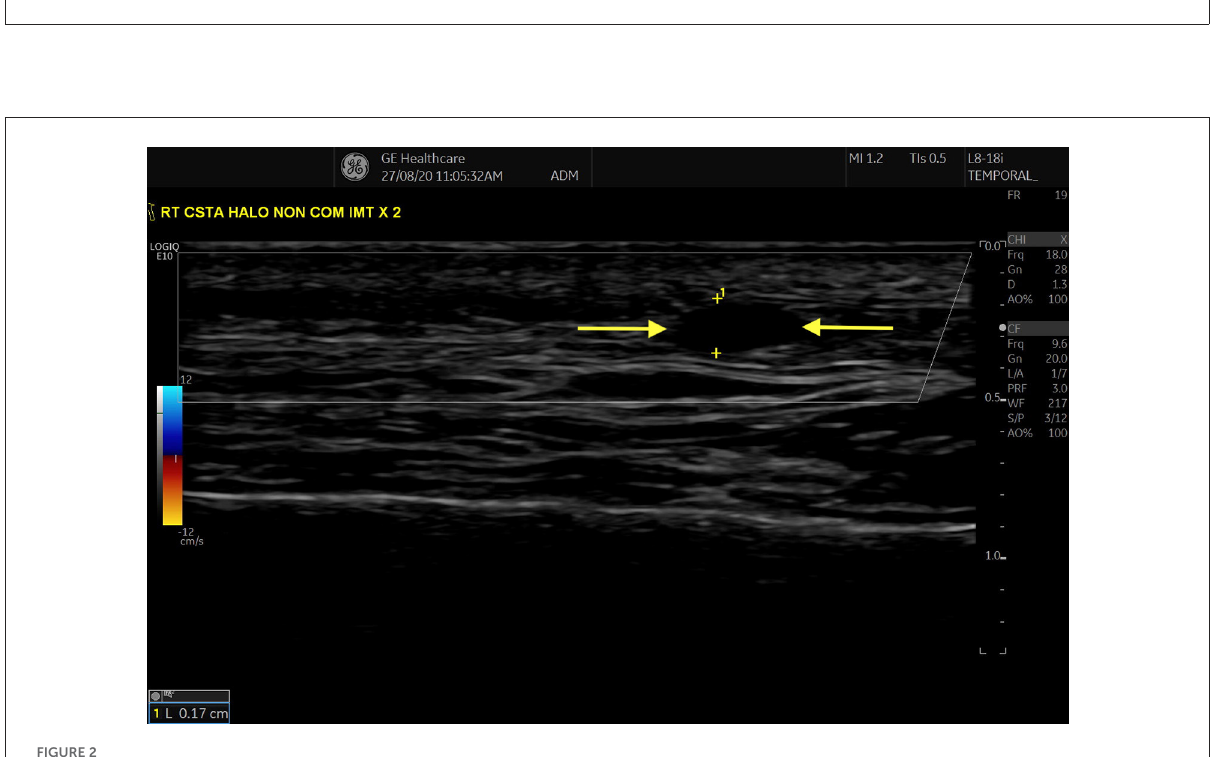
FIGURE1 Transverse view of the frontal branch of the Superficial Temporal Artery, demonstrating a halo sign, as indicated by the anechoic region (green arrow) surrounding the inner Doppler (red arrow) signal.